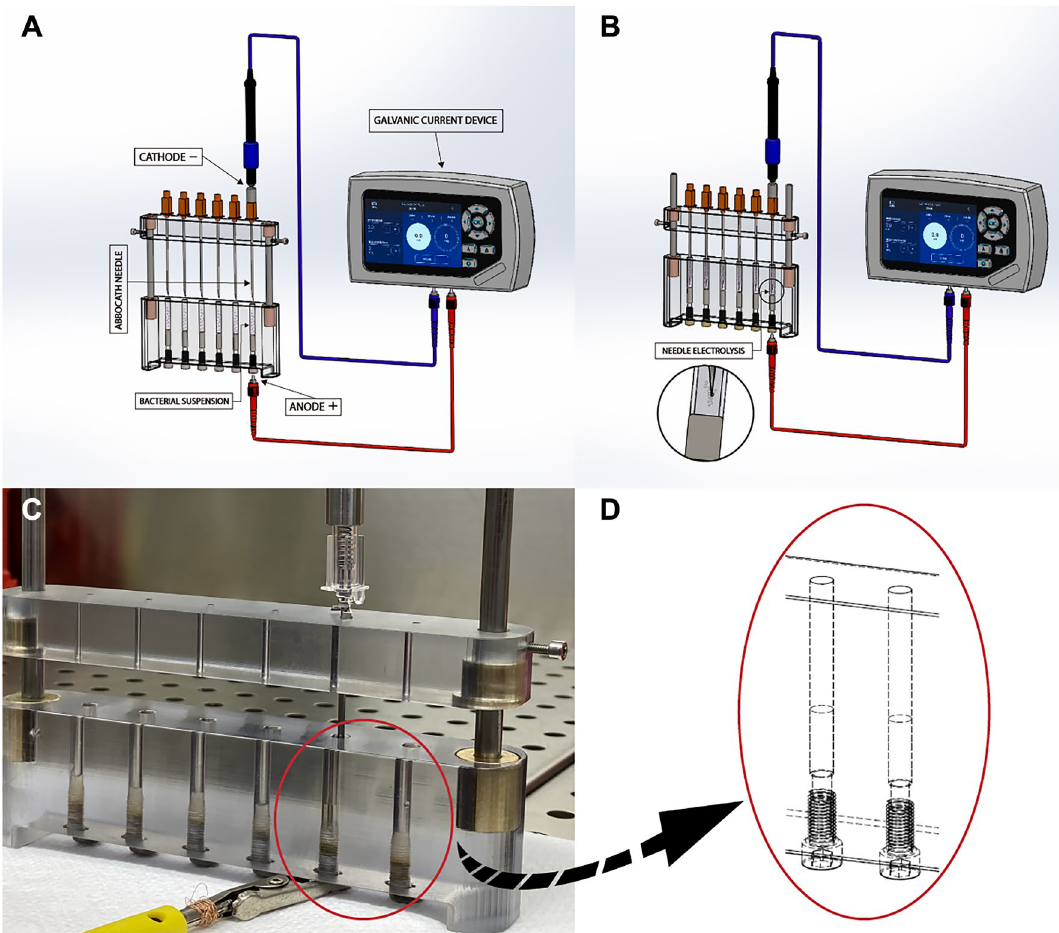
Figure 2. ( A ) Preparing the elements for conducting the experiments . ( B ) NE application through a tri-beveled needle on a bacterial suspension of S. aureus . ( C ) In vitro device for application of needle electrolysis designed to simulate in vivo application conditions. ( D ) Schematic zoom of the receptacle where the cathodic flow of the electrolysis to the bacteria is